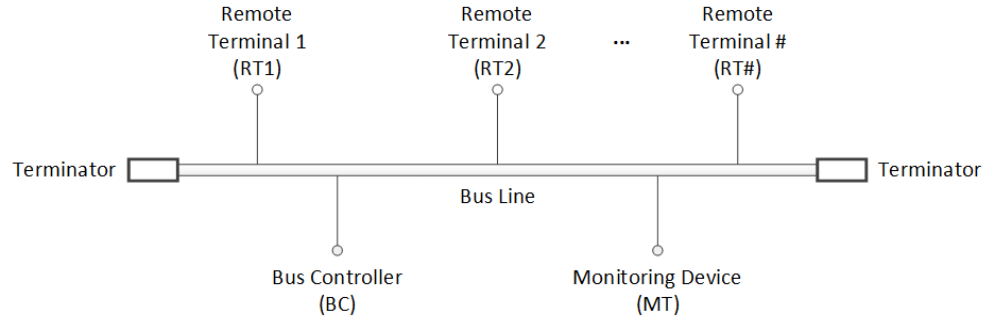
Figure 1. The overall configuration of the MIL-STD-1553B communication system. It consists of a bus controller (BC), multiple remote terminals (RTs), and one or more monitoring devices (MTs).